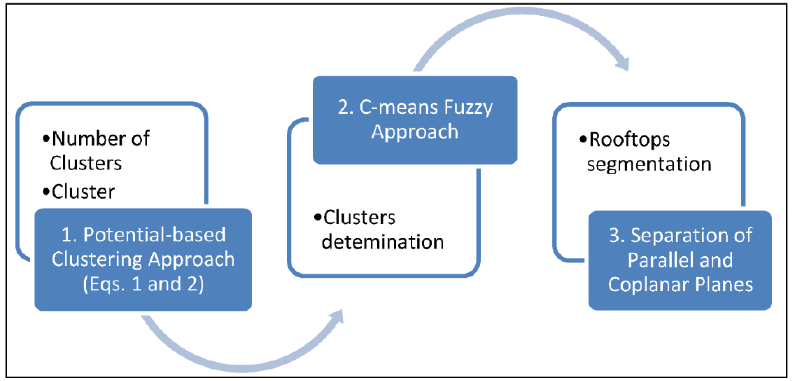
Figure 2. Schematic representation of the workflow of the clustering segmentation approach described in Section